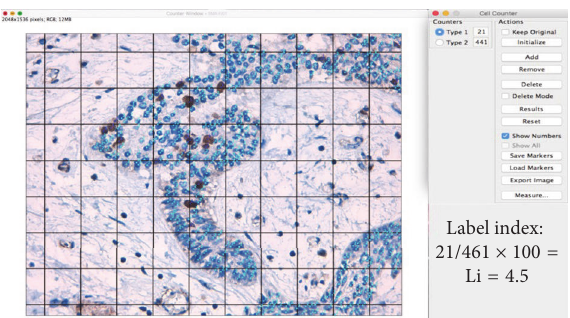
Figure 2: Photomicrograph of a solid ameloblastoma specimen at 400x magnification. This photomicrograph represents the manual cell counting method (DM scoring) using the Grid and Cell Counter plugins. The Grid was constructed with an area-per-point of 17,046 pixels ∧ 2. The light blue dots indicate nuclei negative for DAB or Ki-67 staining. The dark blue nuclei indicate positive DAB and Ki-67 staining (ImageJ, method proposed by Carre´on-Burciaga et al.